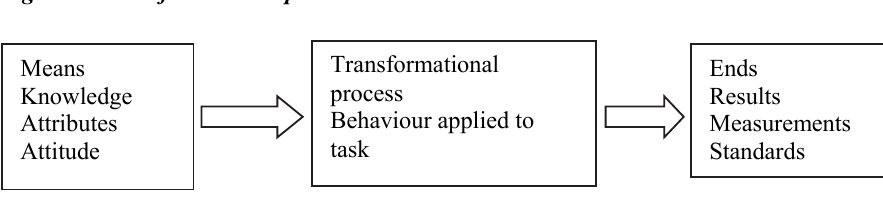
Figure 2: Transformational process model